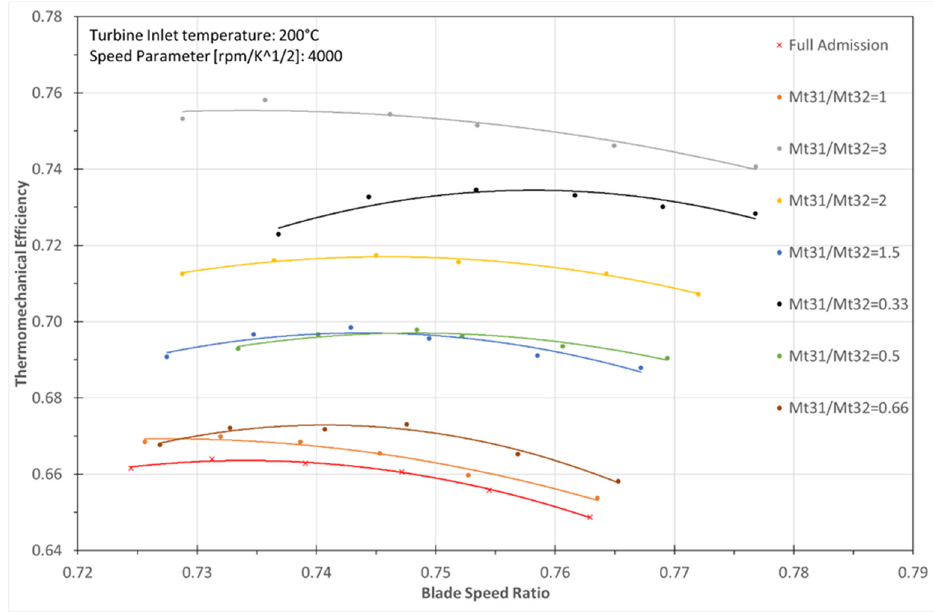
Figure 13. Thermomechanical efficiency vs. blade speed ratio at different unbalanced admission conditions at N t = 4000 . √ K